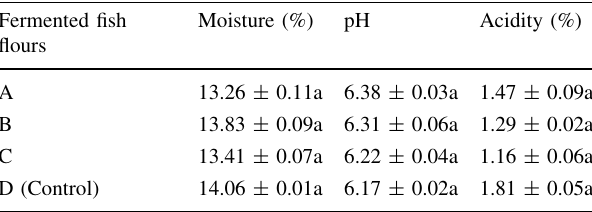
Table 2 Physicochemical characteristics of different types of fer- mented fish flours